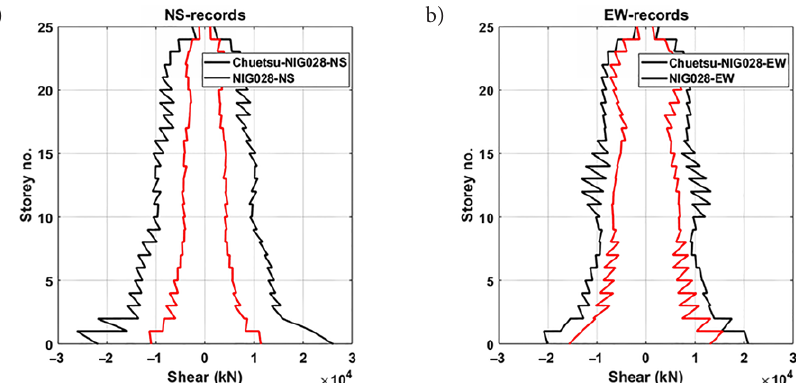
Figure 11. Peak story shear curves vs. story number under the NS and EW components of the Niigata records with and without sequences in the: a – transverse direction and b – longitudinal direction